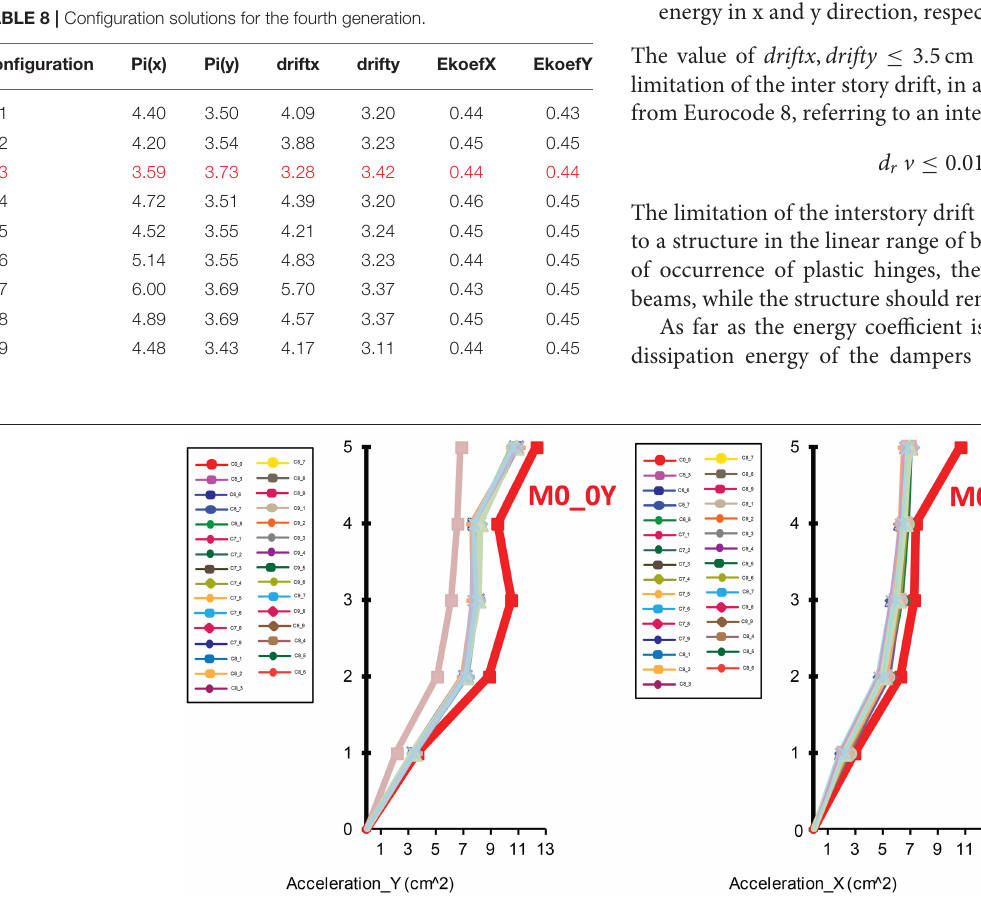
Frontiers in Built Environment |